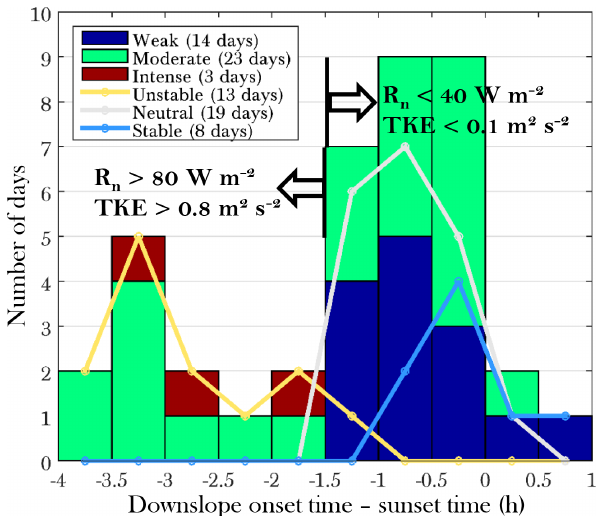
Figure 4. Histograms of the difference between the downslope on- set time and sunset time, for the three groups of intensities (bars) and for different static stabilities at the moment of the onset (lines). Values of the net radiation ( R n ) and turbulent kinetic energy (TKE) are also indicated on both sides from the − 1 . 5h time